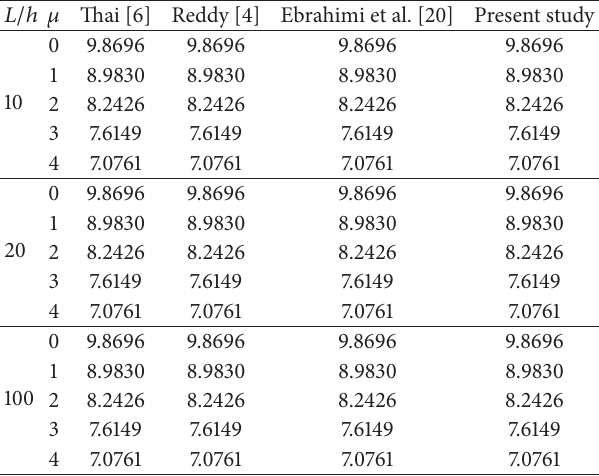
Table 2: Comparison of the dimensionless critical buckling load of simply supported nanobeam.